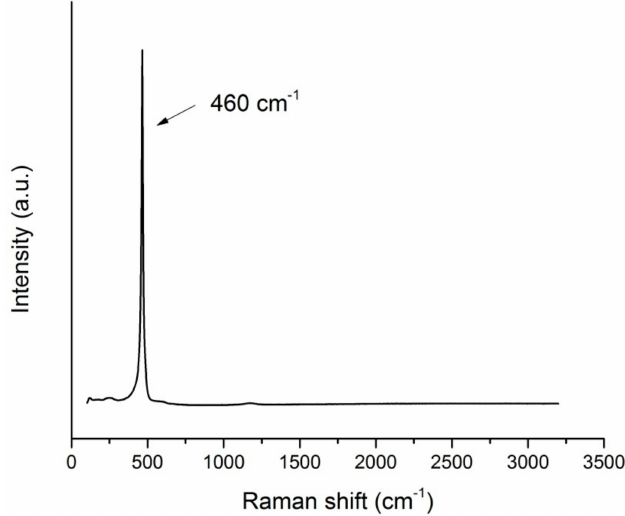
Figure 2. Raman spectrum of CeO 2 nanoparticles synthesized in synthetic